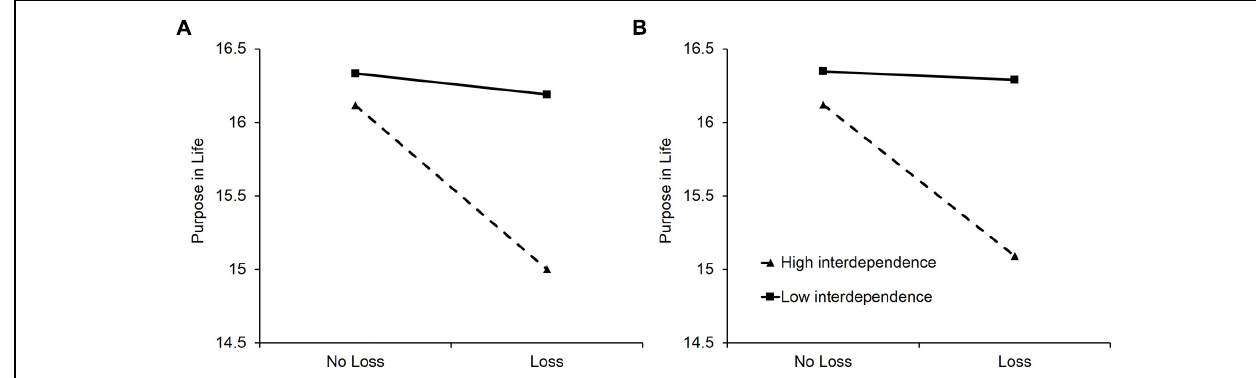
FIGURE 1 | Regression lines predicting purpose in life as a function of losing a child for individuals ± 1 SD from the mean on interdependent self-construal in the cross-sectional (A) and longitudinal (B) analyses.